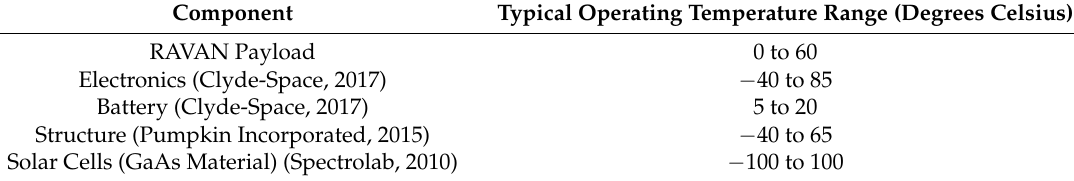
Table 27. Typical Operating temperatures for CubeSat Sub Systems (Clyde-Space, 2017) (Pumpkin Incorporated, 2015)